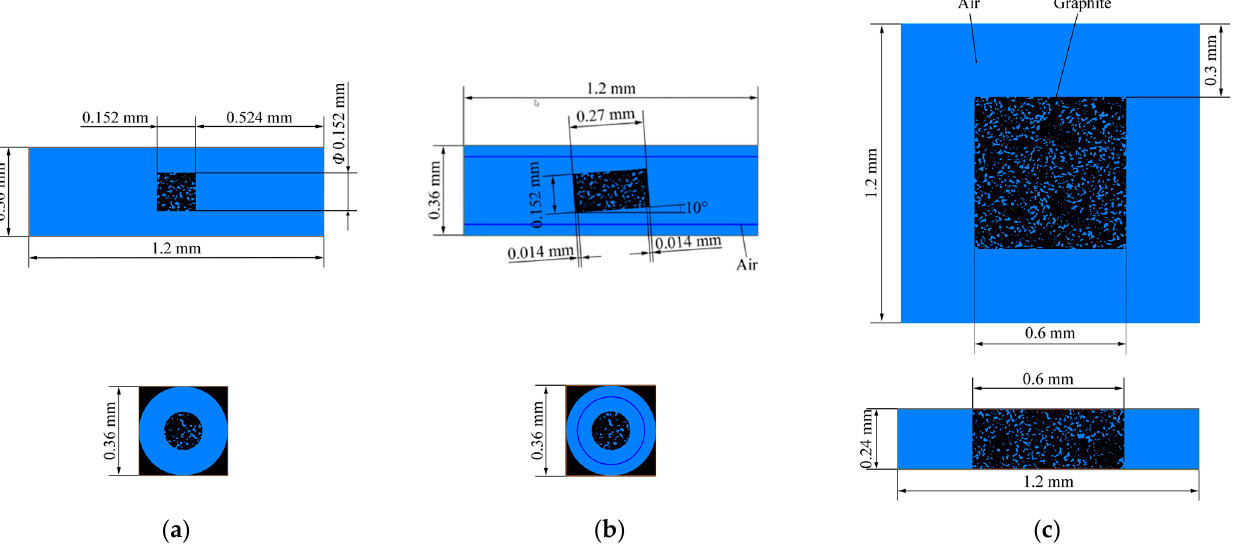
Figure 5. Scaled-down scenarios for the micro-hydromechanics simulation using the real porous structure of graphite ET-10: ( a ) the scaled-down scenario based on the recommended conditions from the ASTM; ( b ) the scaled-down scenario for the partially SiC-coated graphite specimen; ( c ) the scenario for the large pure graphite specimen.